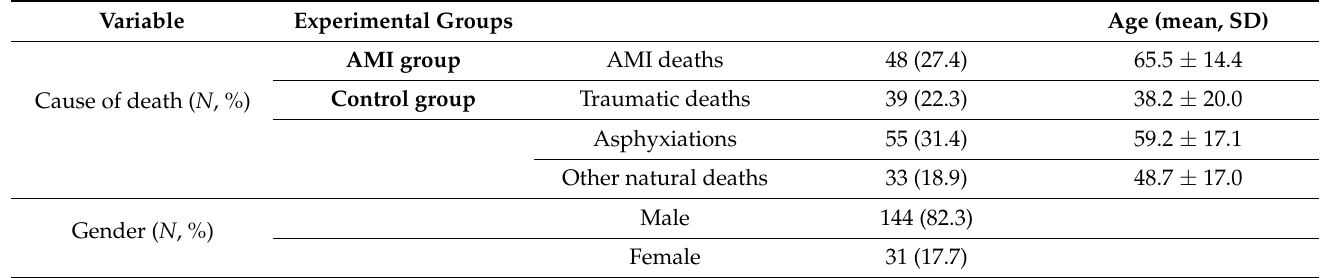
Table 1. Baseline characteristics of included